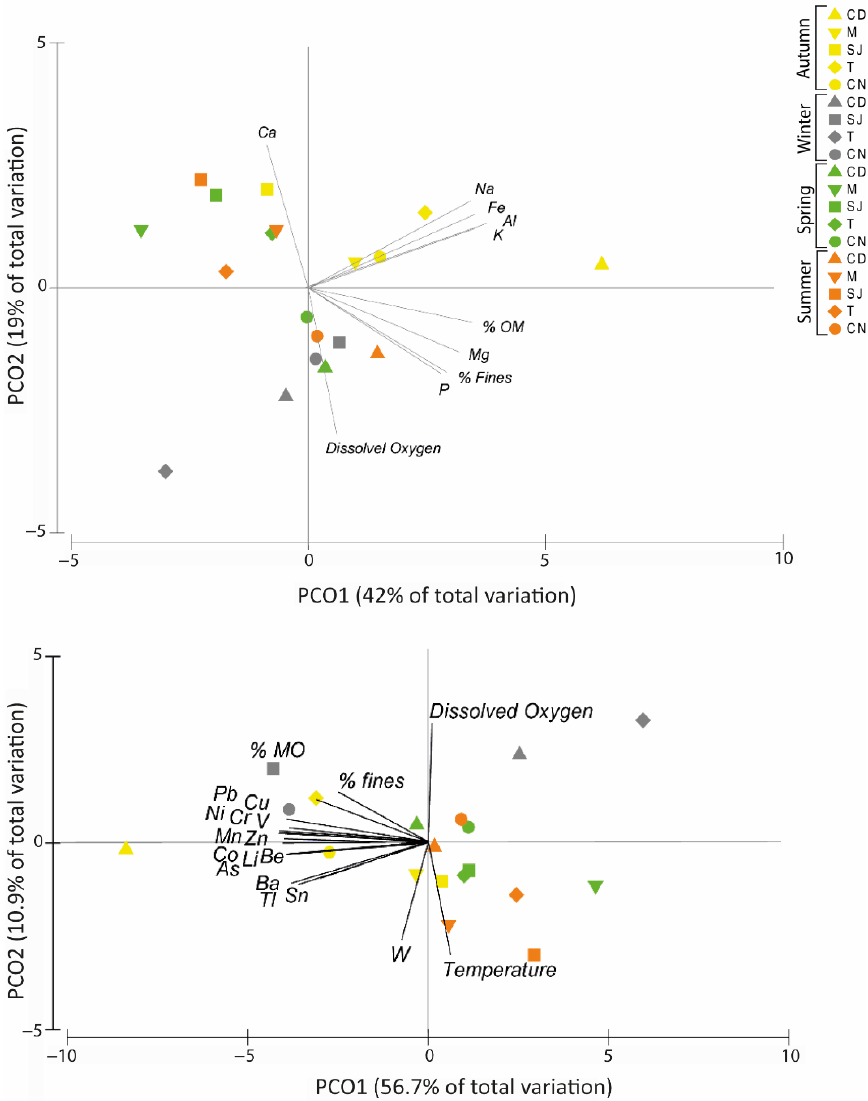
Figure 7. Principal coordinates ordination analysis (PCO) of ( A ) major element concentrations in sediments and physical and chemical parameters and ( B ) trace element concentrations in sediments and physical and chemical parameters. (r > 0.7). CD, M, SJ, T, and CN represent the sites Cale do